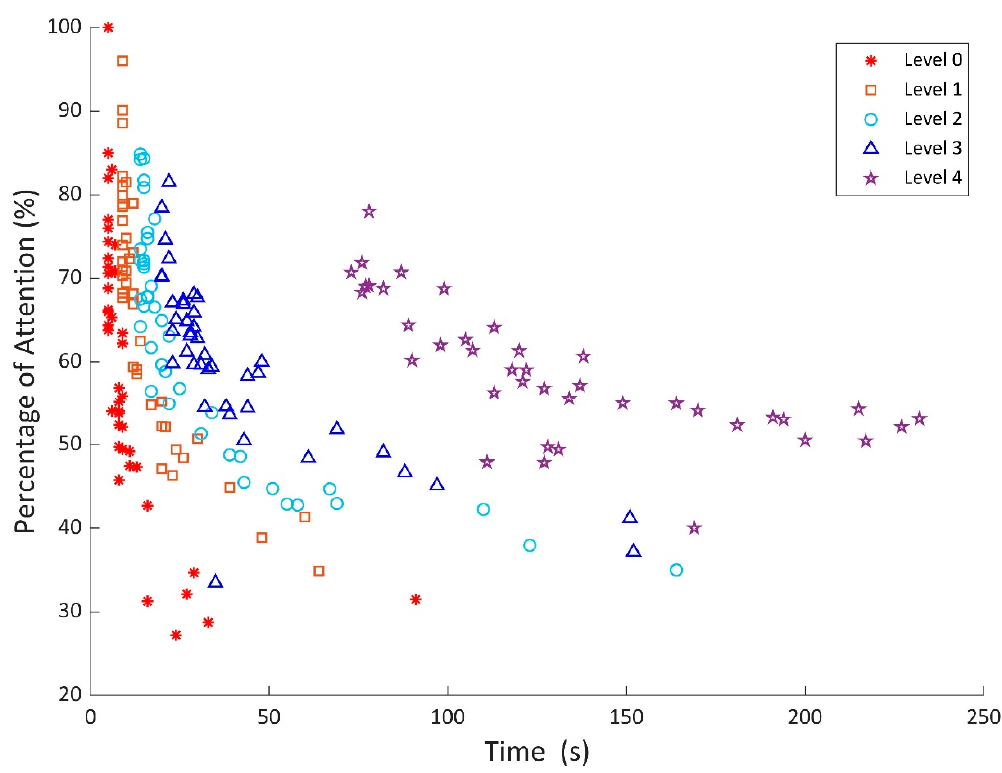
Figure 2. Mean attention values versus completion time for each level. As expected, these two variables follow an inverse relationship in each level.